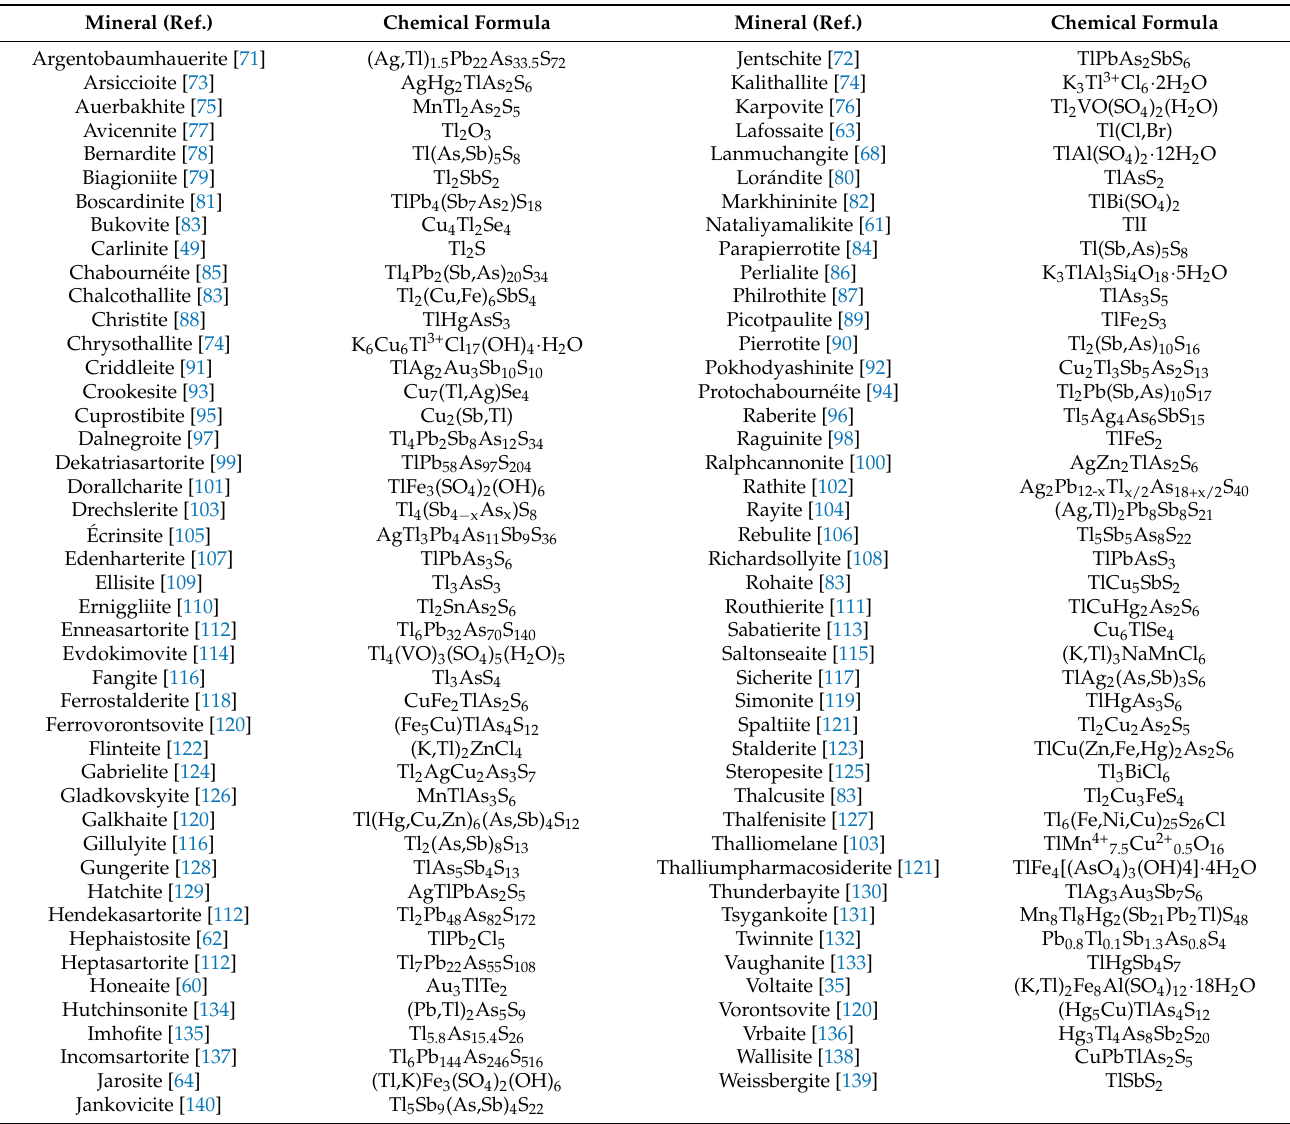
Table 1. Independent thallium